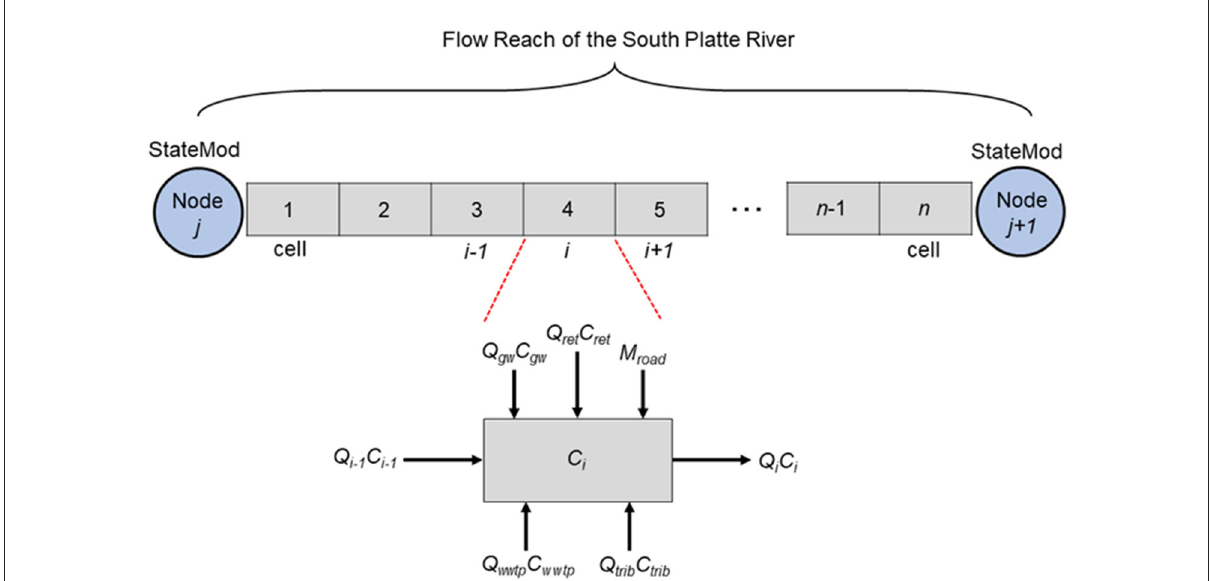
FIGURE4 Schematic of the salt transport model of the South Platte River, showing n salt mass balance grid cells (control volumes) between two StateMod flow model nodes. Salt inputs and outputs for each grid cell can consist of groundwater discharge ( gw ), surface water return flows ( ret ), road salt ( road ), wastewater treatment plant effluent ( wwtp ), and tributary inflow ( trib ). Q , C , and M represent flow rates, concentrations, and mass, respectively.